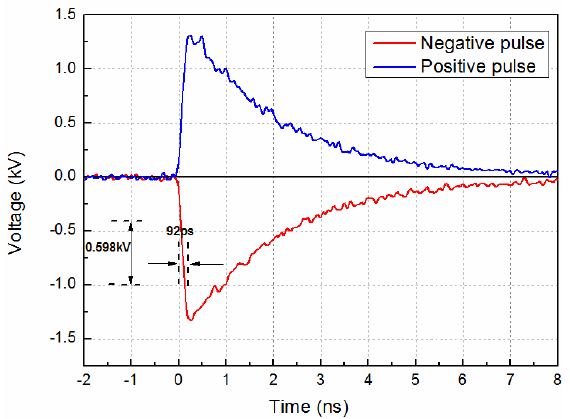
Figure 4. The output waveform at a bias voltage of ± 2.0 kV and a laser pulse energy of 97.5 μJ .